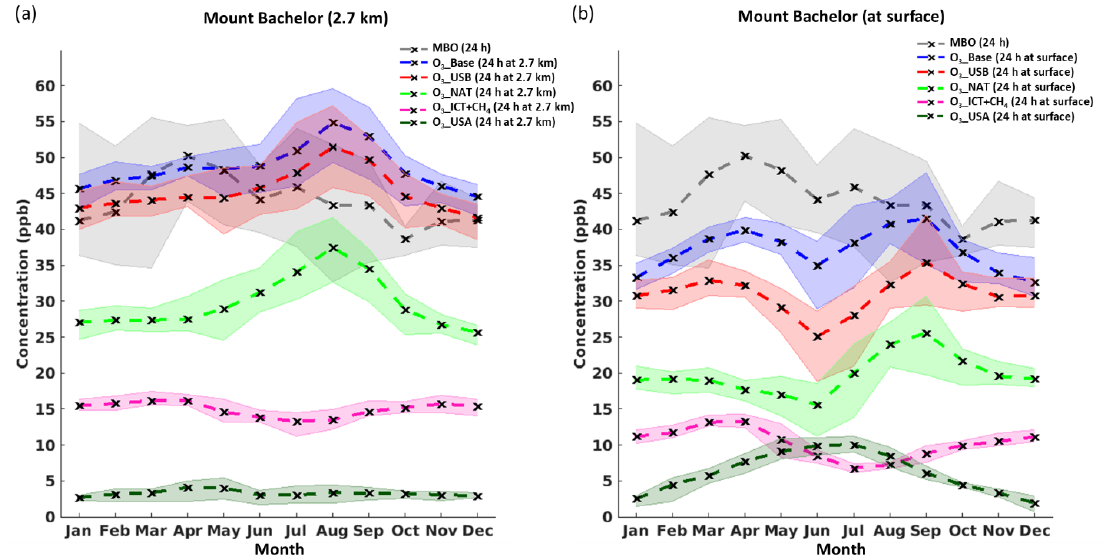
Figure 3. Monthly 2004–2012 average 24h O 3 concentrations at Mount Bachelor Observatory. Observations (grey) are the same in both panels. Simulations from the GEOS-Chem model are sampled in the grid cell containing Mount Bachelor at (a) 2.7km (the height of the Mount Bachelor Observatory) and at (b) the surface: O 3 _Base (blue), O 3 _USB (red), O 3 _NAT (light green), O 3 _ICT + CH 4 (pink), and O 3 _USA (dark green). The shaded ranges span the highest and lowest